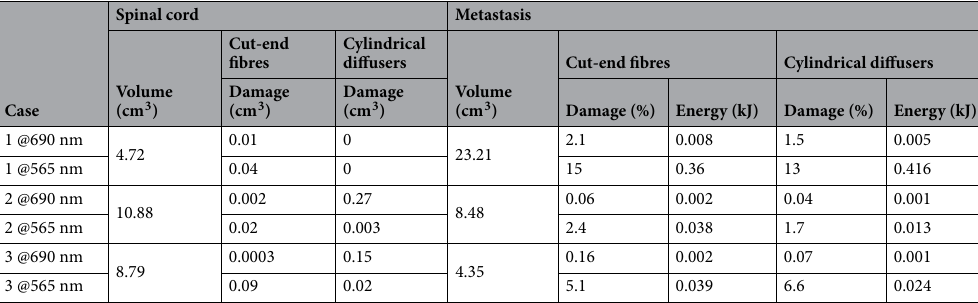
Table 5. PDT induced tumour volume reduction in the metastatically involved vertebrae as a function of wavelength and photon source for near complete preservation of the spinal